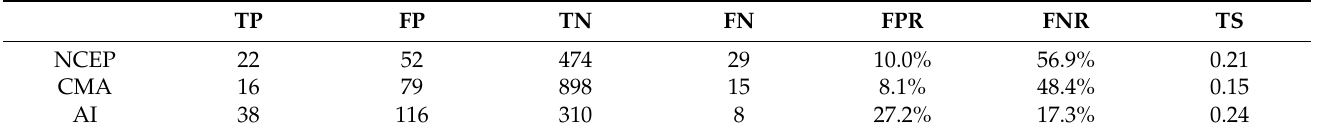
Table 2. Comparison table between the AI algorithm and different subjective and objective